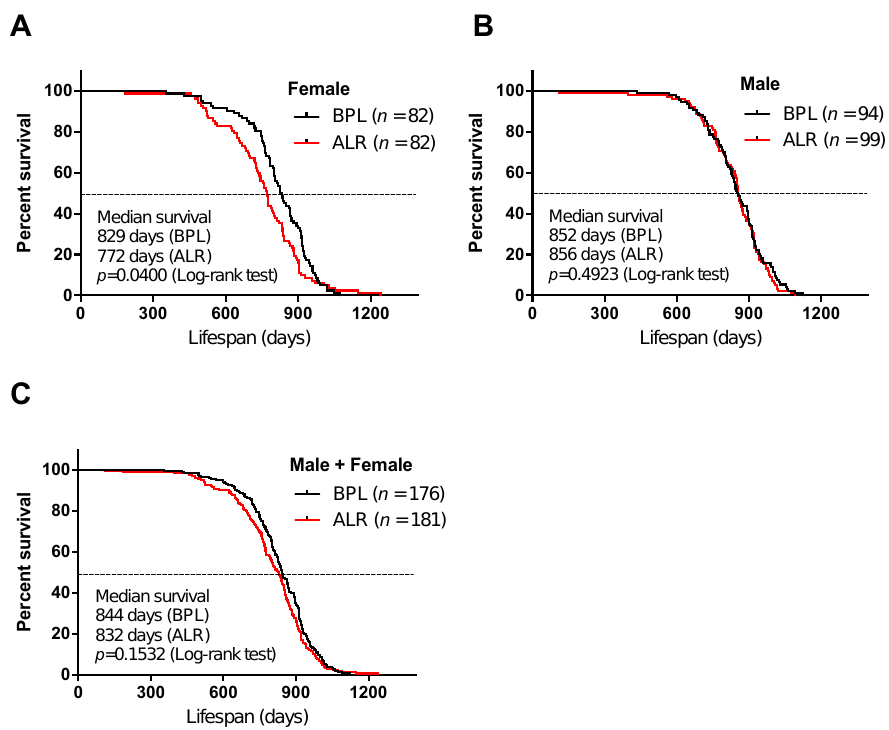
Figure 1. Lifespan study of B6-mt ALR and B6-mt BPL mice. ( A – C ) Survival curve of B6-mt ALR and B6-mt BPL mice. Females ( A ), males ( B ) and both sexes ( C ). BPL: B6-mt BPL ; ALR: B6-mt ALR .